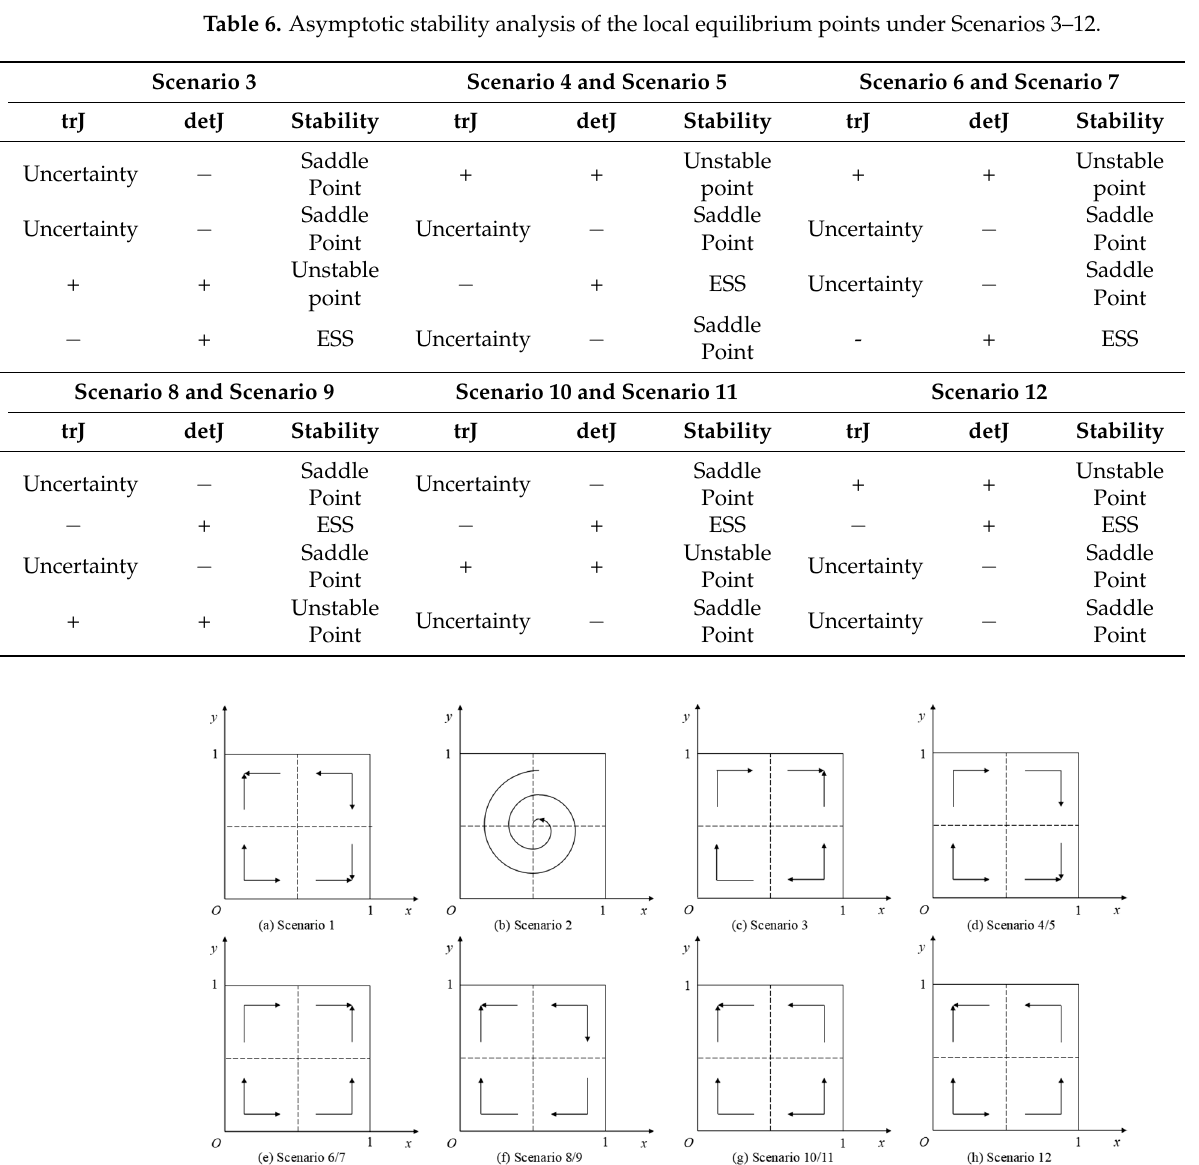
Figure 2. Phase diagram of the evolutionary game between the local governments and herders.